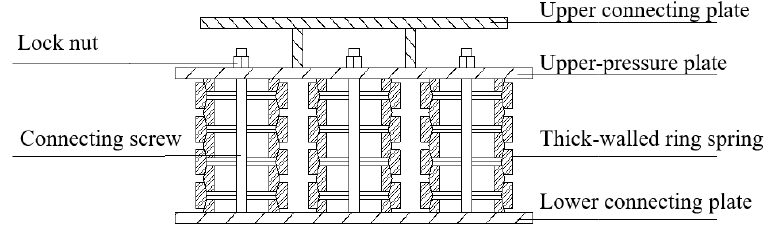
Figure 10. Schematic diagram of the structure of a new ring spring